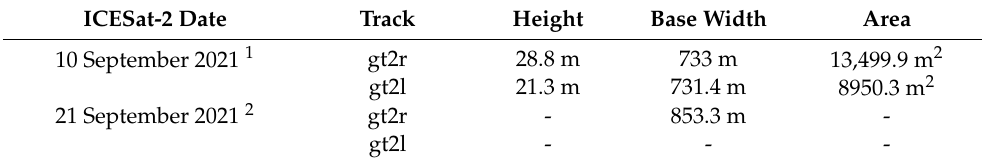
Figure 3. Planet imagery of Niijima Fukutoku-Okanoba over a three-week period showing the erosion over roughly six weeks. The exposed right section of emergent volcano (originally a tuff cone) is completely eroded within the first few weeks of eruption. Table 1. Physical extent calculations (height, width, and area) of exposed surface transects using ICESat- 2 ground-labeled photons. Note: Extracting physical parameters is only possible for the 10 September 2021 collection due to the discontinuous photon return for the 21 September 2021